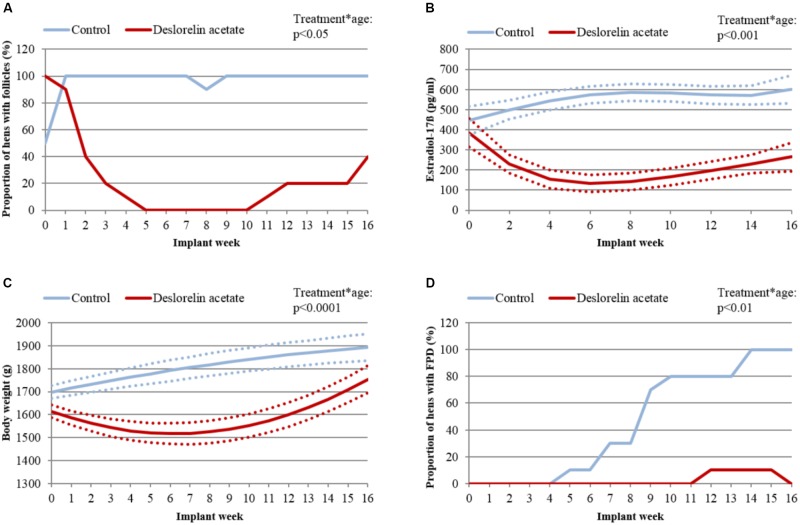
Hens with follicles, estradiol-17ß concentrations, body weight and hens with foot pad dermatitis (FPD) of group “Adult”. (A) Proportion of control (blue line) and treated hens (red line) with follicles on the ovary. (B) Least squares means (LSM; continuous lines) and upper and lower bounds of the 95% confidence interval (dotted lines) of estradiol-17ß in plasma in control (blue) and treated hens (red). Missing overlap of lines indicates a significant difference (p < 0.05) between groups. (C) LSM (continuous lines) and upper and lower bounds of the 95% confidence interval (dotted lines) of body weight of control (blue) and treated hens (red). Missing overlap of lines indicates a significant difference (p < 0.01) between groups. (D) Proportion of hens with FPD of control (blue) and treated hens (red).